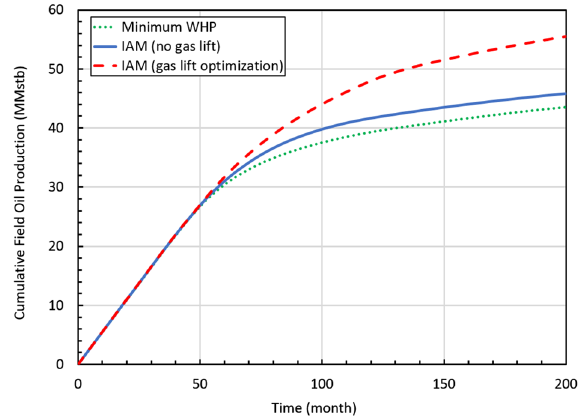
Fig. 10 Comparison of cumulative production for three production forecasts: (1) isolated approach with minimum WHP as boundary condition, (2) integrated approach without gas lift and (3) integrated approach with gas lift optimization